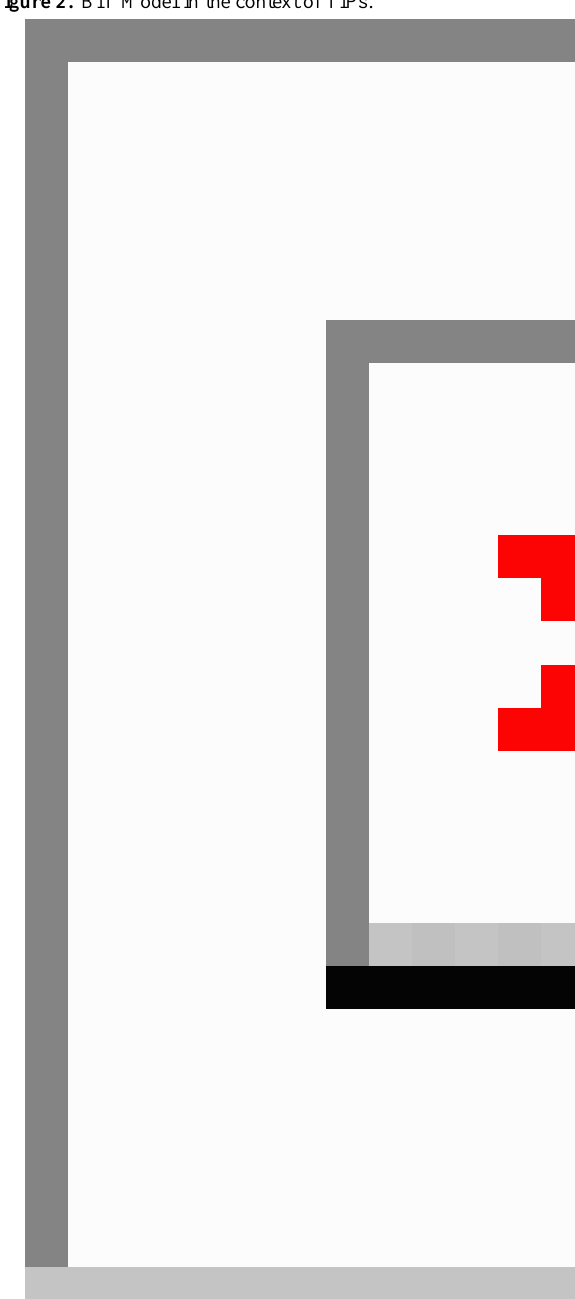
Figure 2. BIT Model in the context of